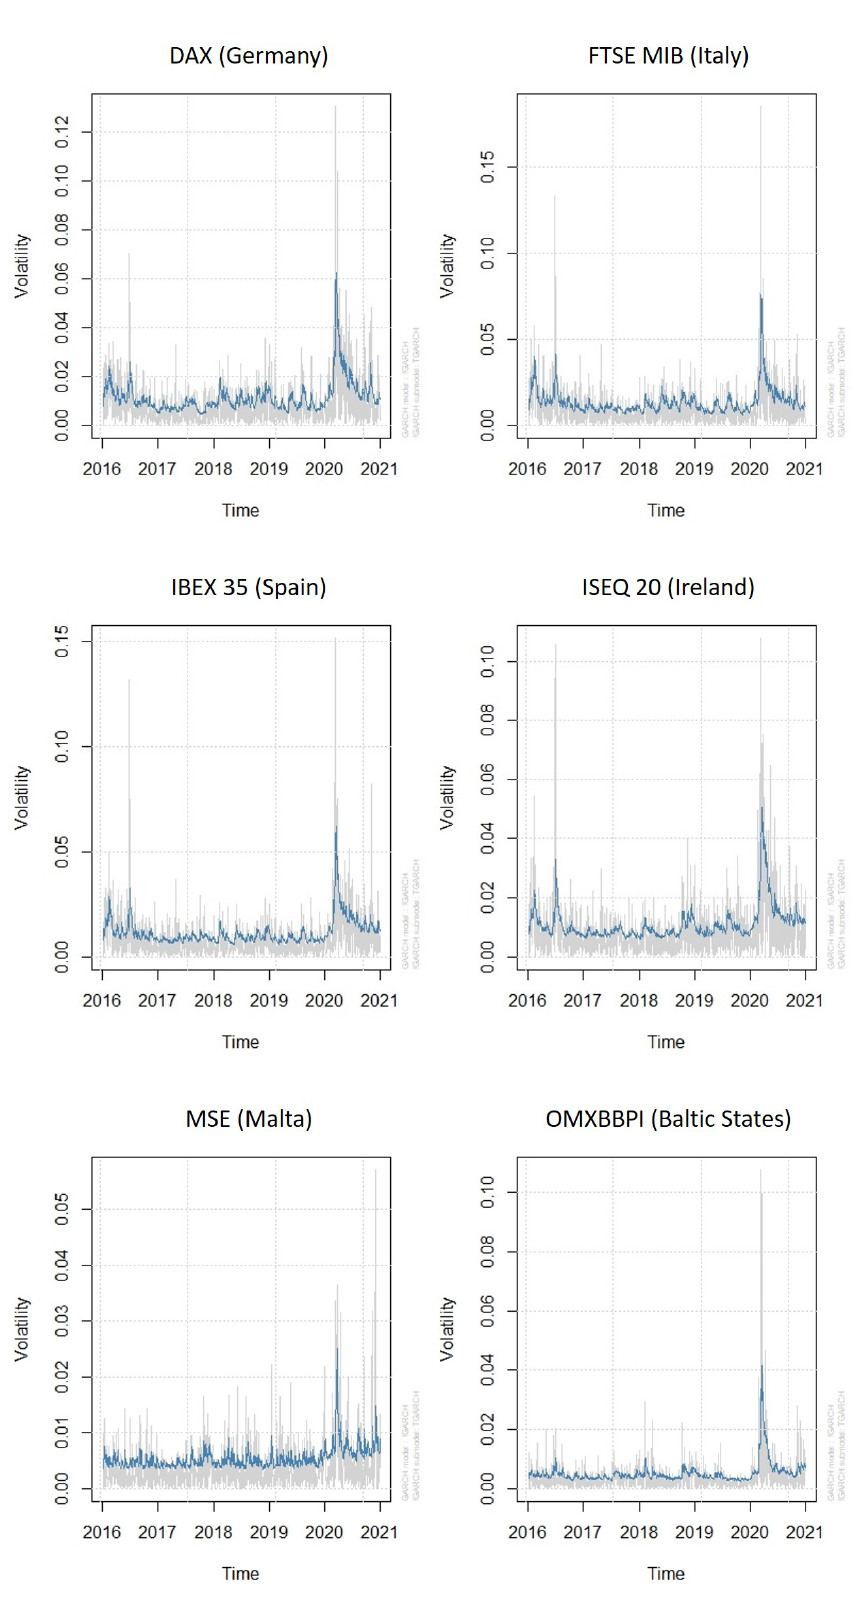
Figure A2. Estimated conditional standard deviation (volatility) versus absolute daily returns of euro area stock indices. Period from 4 January 2016 to 31 December